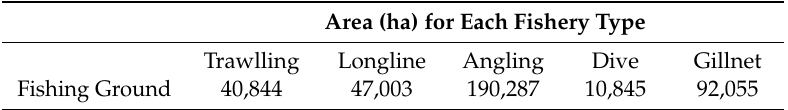
Table 1. Fishery types and ground areas. Dive includes spearfishing and shellfishing, and Gillnet includes bottom fishing net and fishing